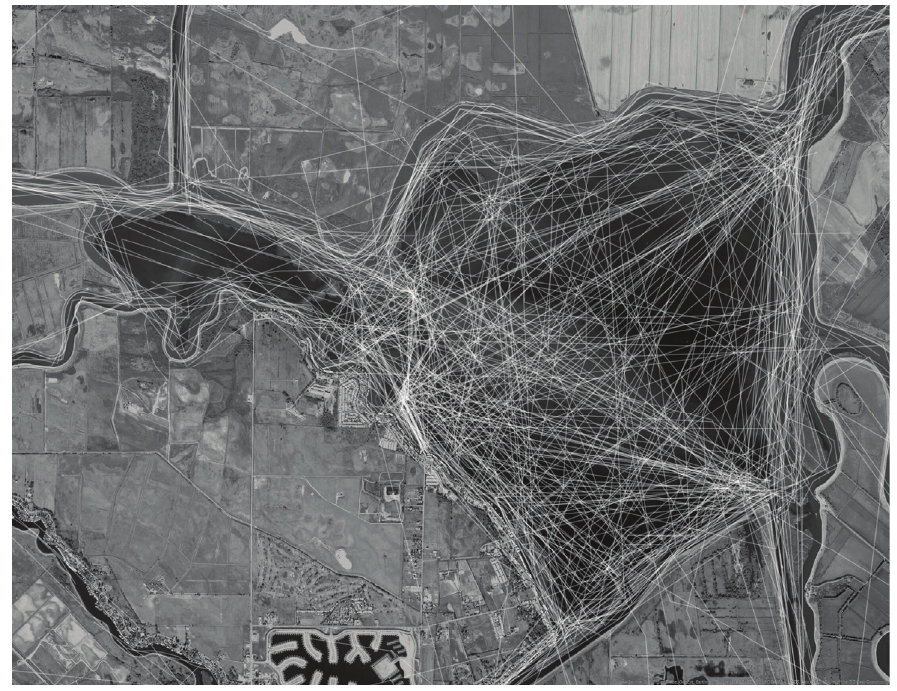
Figure 8. ( a ) Tidal marsh survey responses. ( b ) Superimposed on preferred